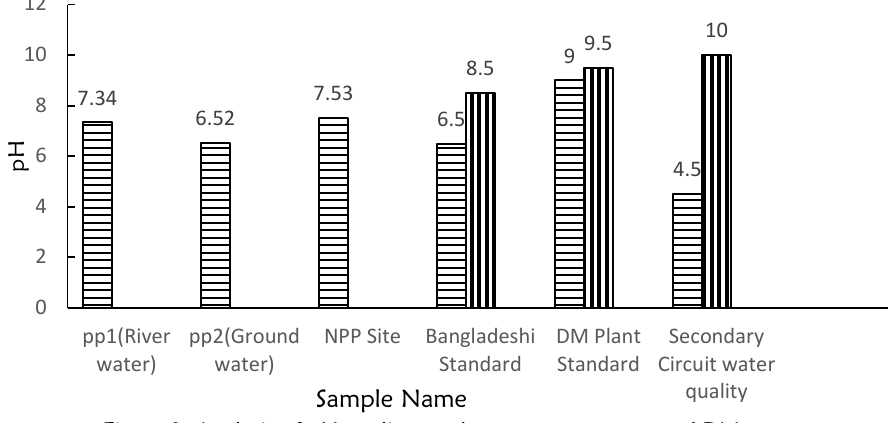
Figure 2: Analysis of pH quality gap between raw water and DM water.